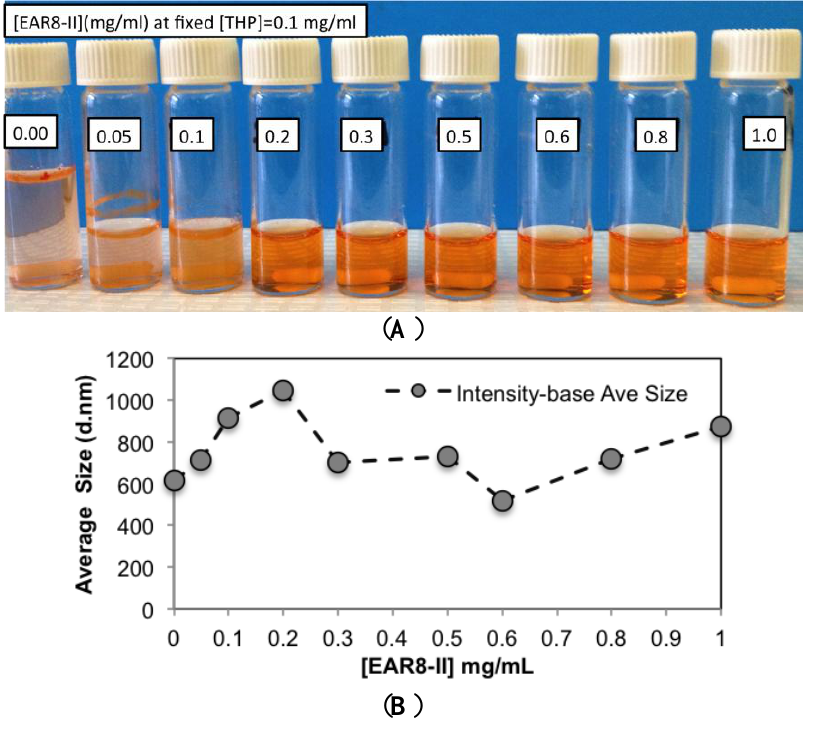
EAR8-II:THP mass ratios. (From left to right: THP in water, 1:2, 1:1, 2:1, 3:1, 5:1, 6:1, 8:1, 10:1 mass ratios); ( B ) Intensity-base average hydrodynamic diameter of EAR8-II-THP complexes at fixed [THP] = 0.1